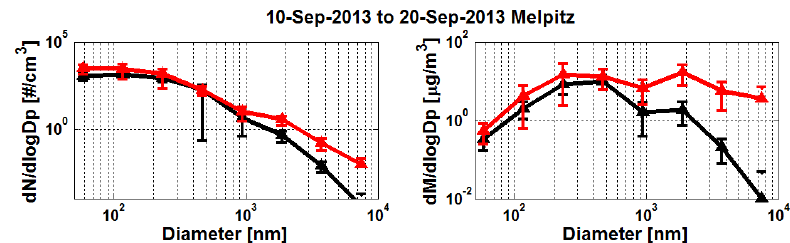
Figure 3. Comparison of Particle Number Size Distribution (PNSD, left) and Particle Mass Size Distribution (PMSD, right) between WRF- Chem model and Melpitz measurements. Model results indicated by the red lines and measurements by the black lines. The size distributions are averaged in the period 10–20 September 2013, the error bar indicates the upper and lower